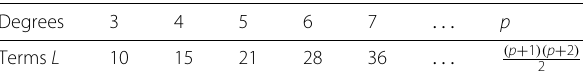
Table 1 The relationship of the degrees and terms for basis function